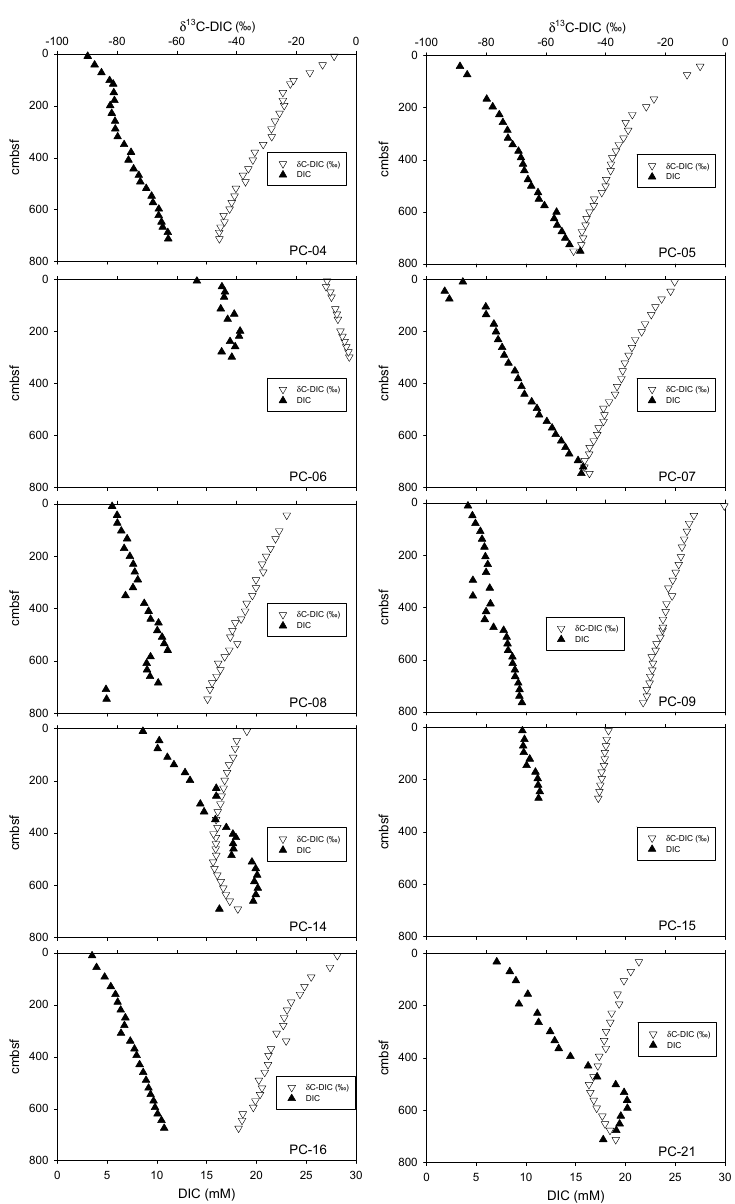
Figure 5. Porewater DIC concentrations and DIC stable carbon isotope ratios ( δ 13 C-DIC) vs. depth (CMBSF) for AC-07 piston cores (PC). Core PC-06 contained solid phase hydrates which destabilized during